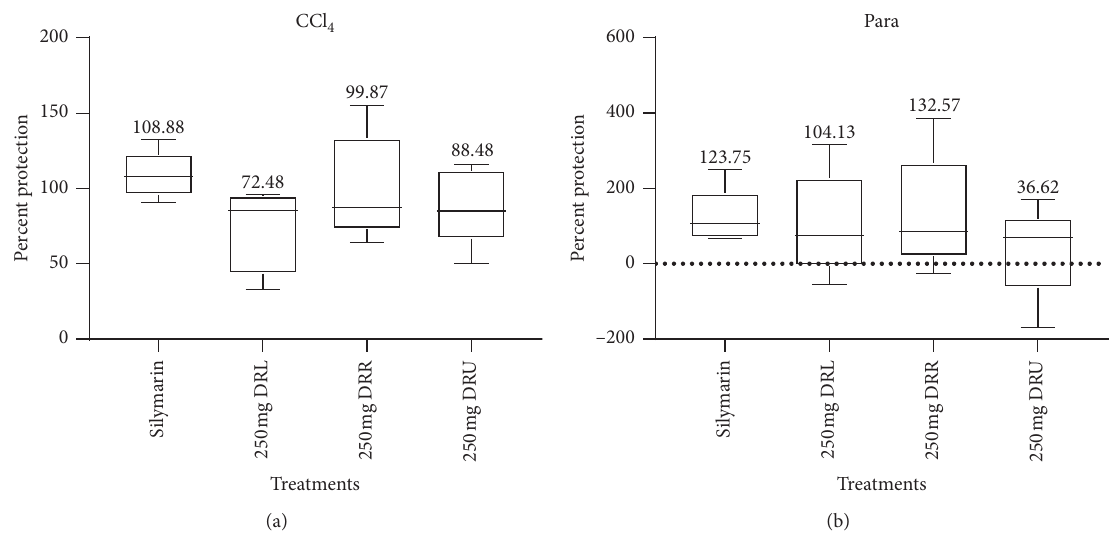
4 and acetaminophen.